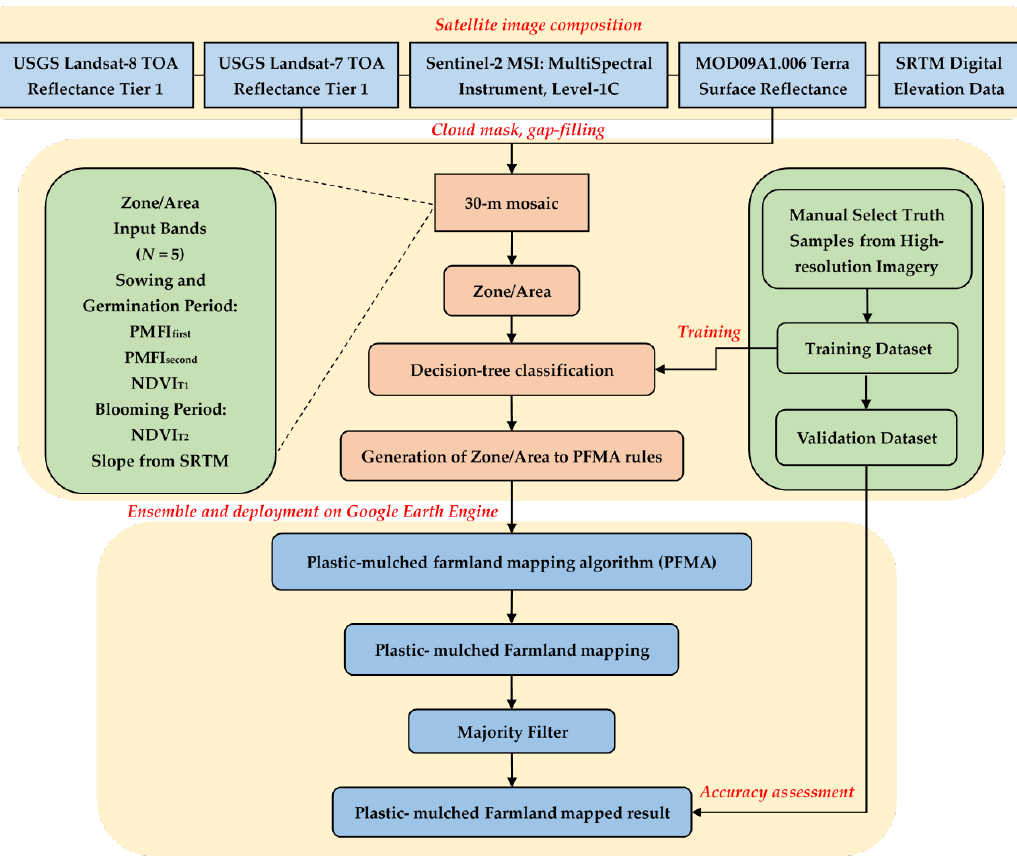
Figure 3. Overview of the methodology for PMF mapping and plastic-mulched farmland mapping algorithm (PFMA) for